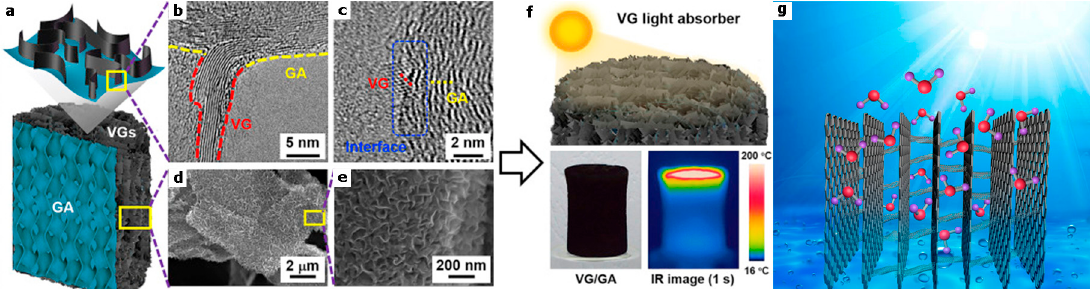
Figure 9. ( a ) Schematic of VG/GA; ( b , c ) high-resolution TEM images of VG/GA; ( d , e ) SEM images of VG/GA; ( f ) IR image of VG/GA [79] Reproduced with permission. Copyright 2019, ELSEVIER; and ( g ) schematic illustration of VA-GSM [80] Reproduced with permission. Copyright, American Chemical Society.